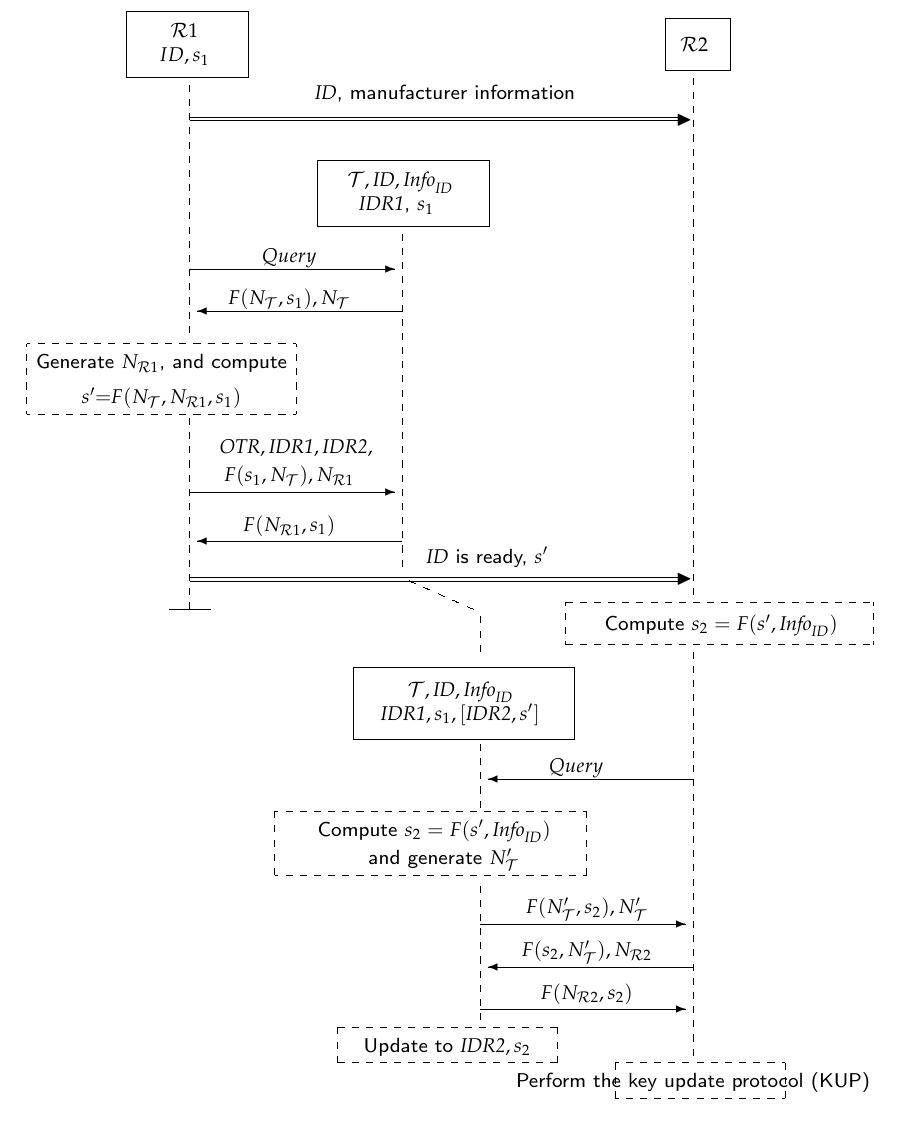
Figure 6. The ownership transfer protocol.